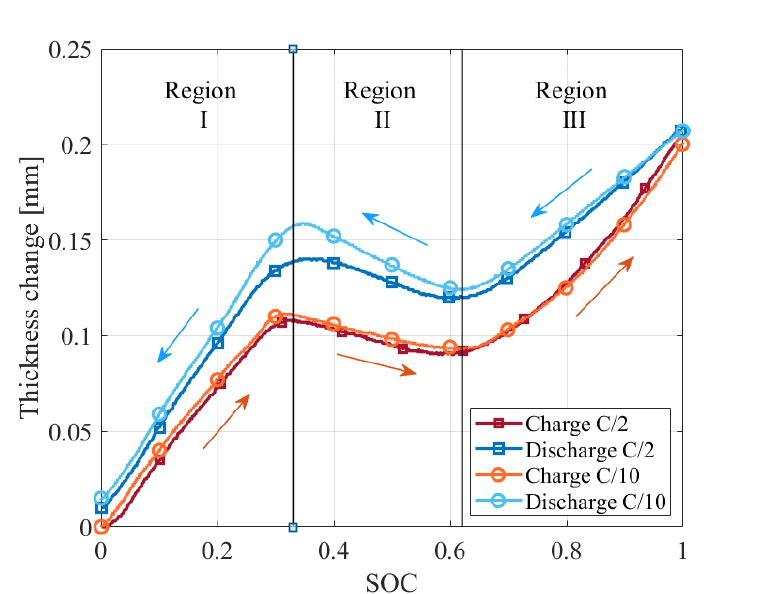
Figure 8. Hysteresis of thickness change between charge (red shadows) and discharge (blue shadows) at different C rates: dark shadows identify C/2 rate and light shadows identify C/10 rate. Arrows of respective colour show the path